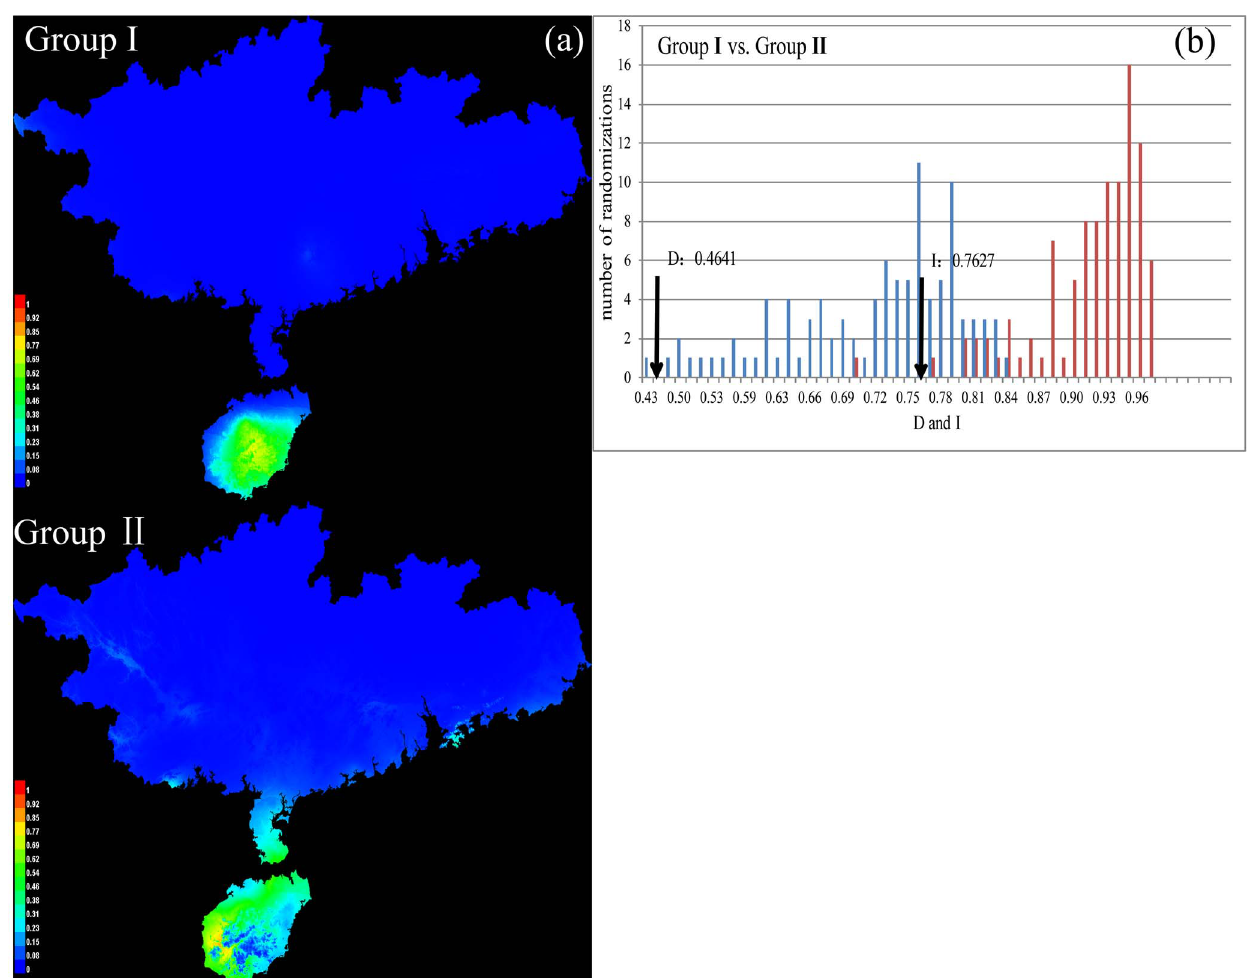
Figure 4. (a) Predicted distributions of Groups I and II generated in Maxent. (b) The results of a niche identity test. Blue columns indicate the null distribution of D, which measures the similarity of two niches. Red columns indicate the null distribution of I, which is an measure of similarity based on the probability distributions of two ecological niche models. The x-axis indicates the value of D and I , whereas the y-axis shows the number of randomizations. The arrow indicates the value in actual Maxent